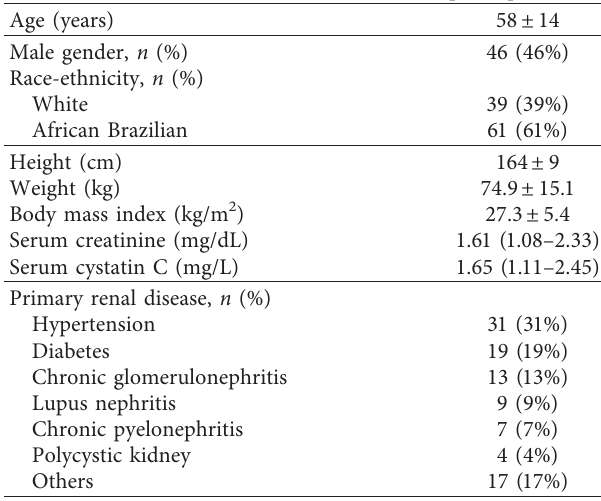
Table 2: General characteristics of the 100 participants.